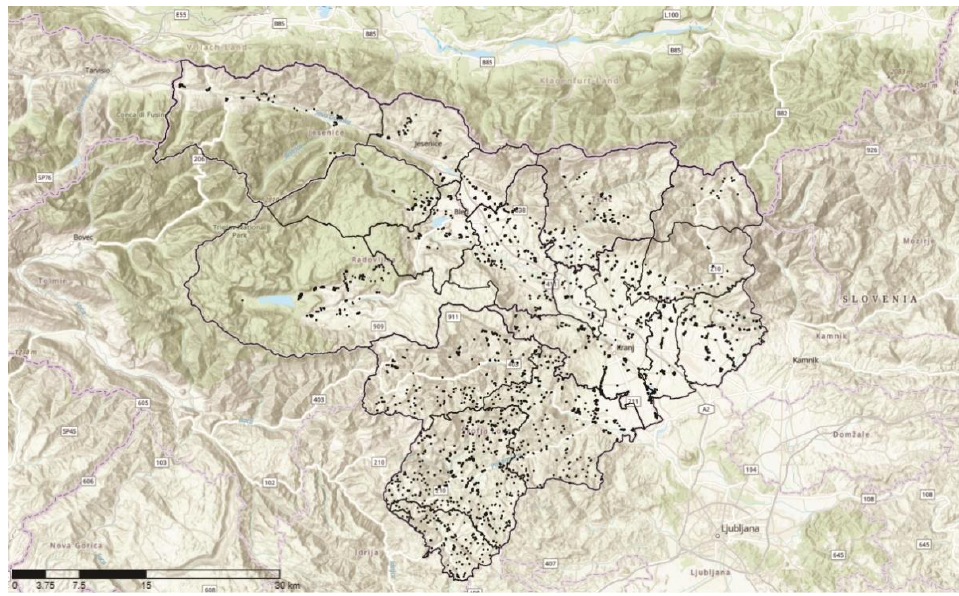
Figure 2. Geographical distribution of livestock farms in Gorenjska region.